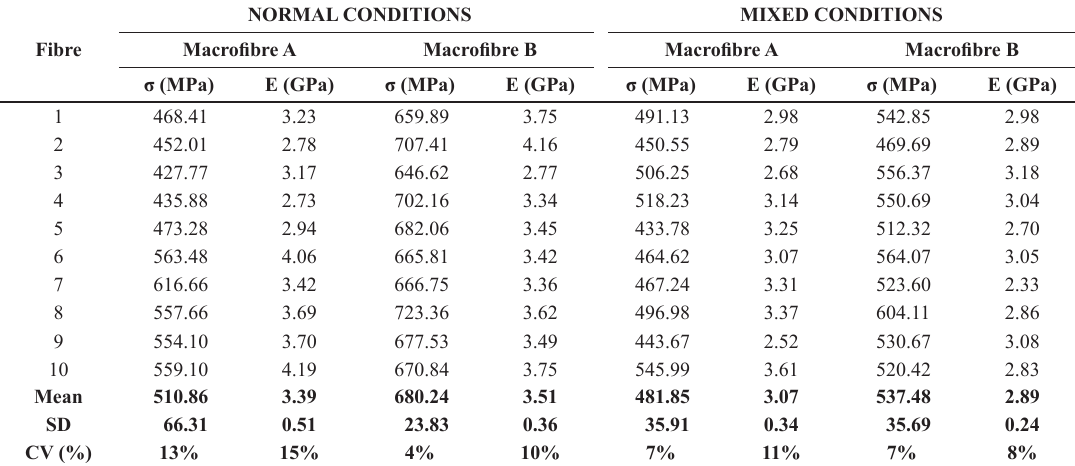
Table 4- Maximum tensile stress and modulus of elasticity of macrofibres under normal and mixed conditions NORMAL Fibre